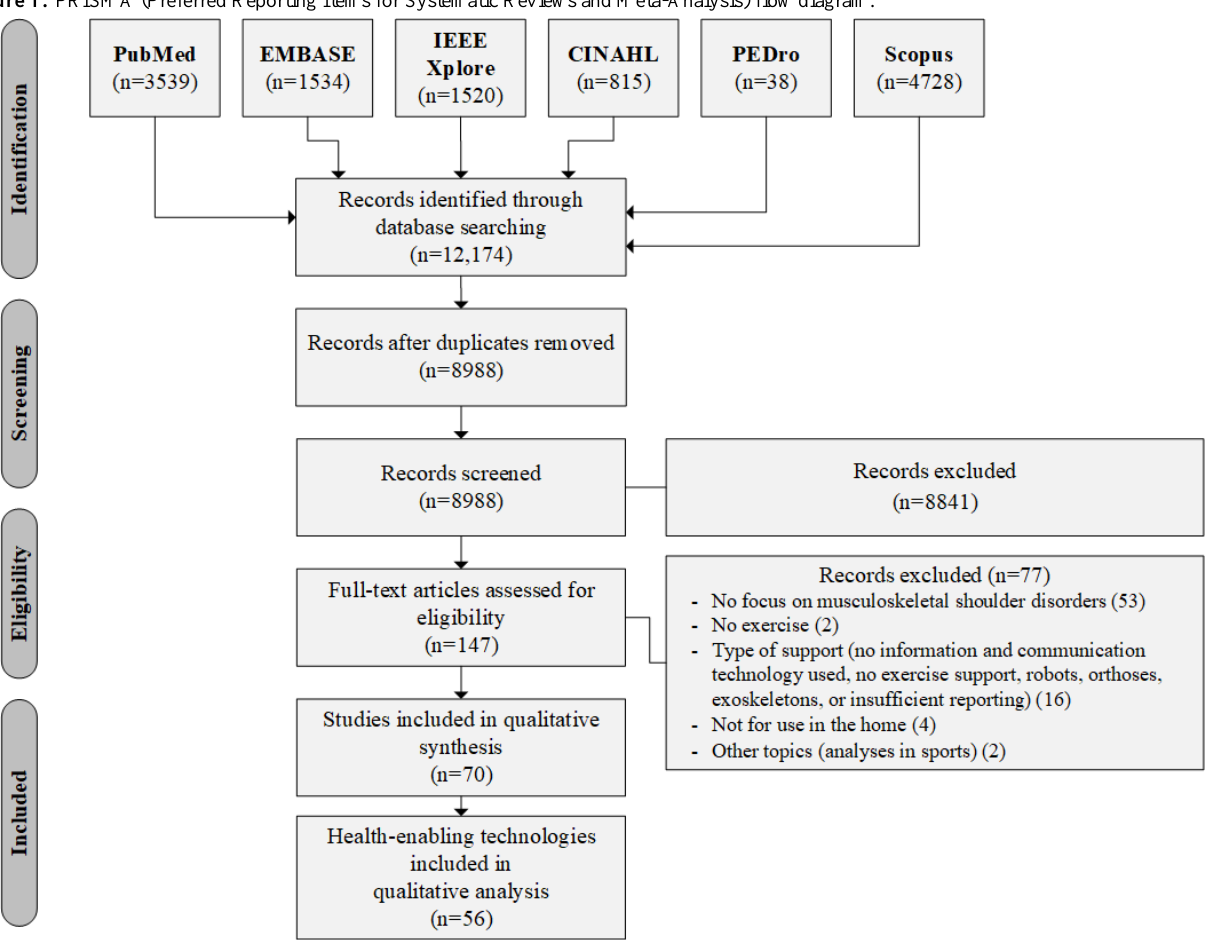
Table 1. Target groups connected to musculoskeletal shoulder disorders in descending order of frequency.